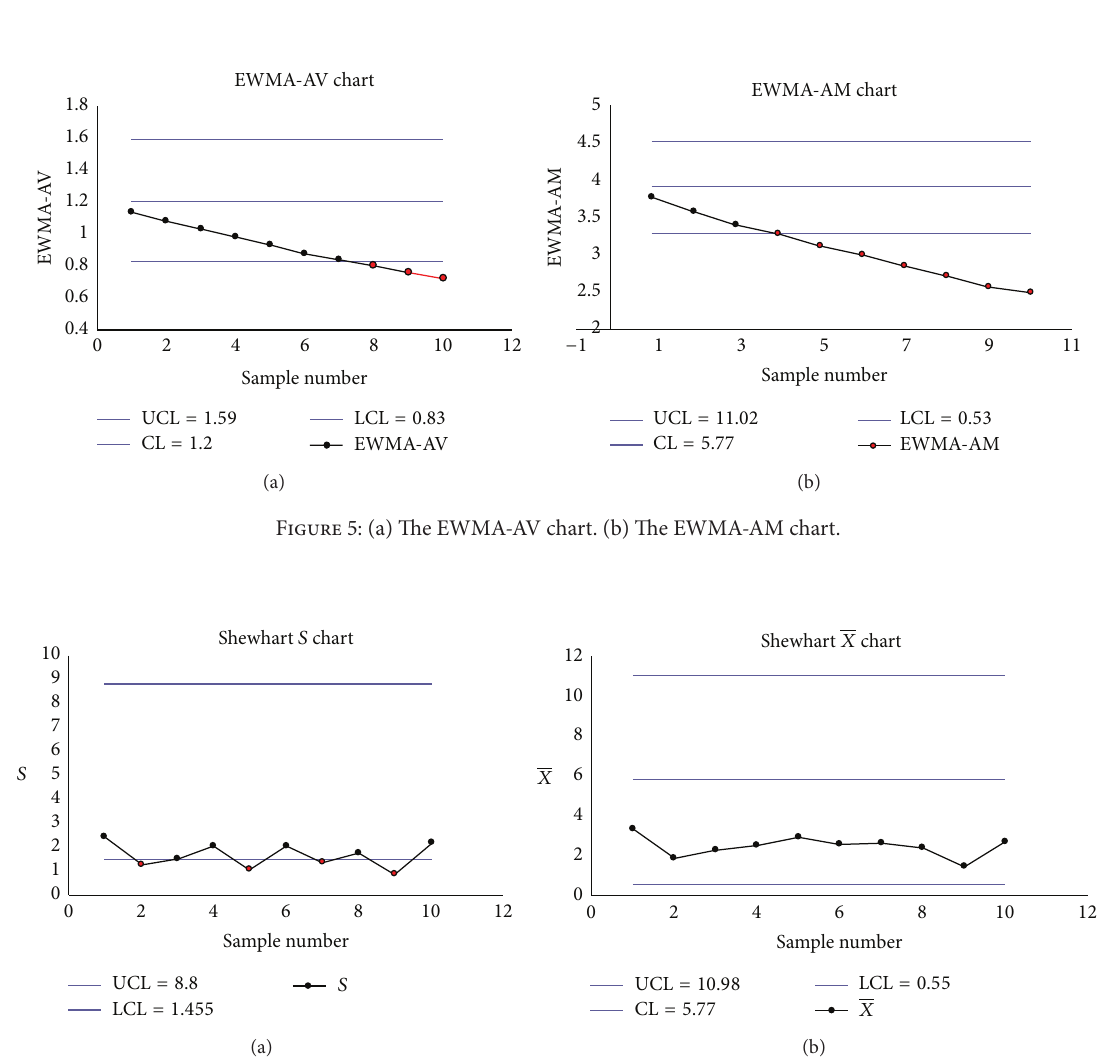
Figure 4: (a) The EWMA 𝑆 chart. (b) The EWMA 𝑋 chart.